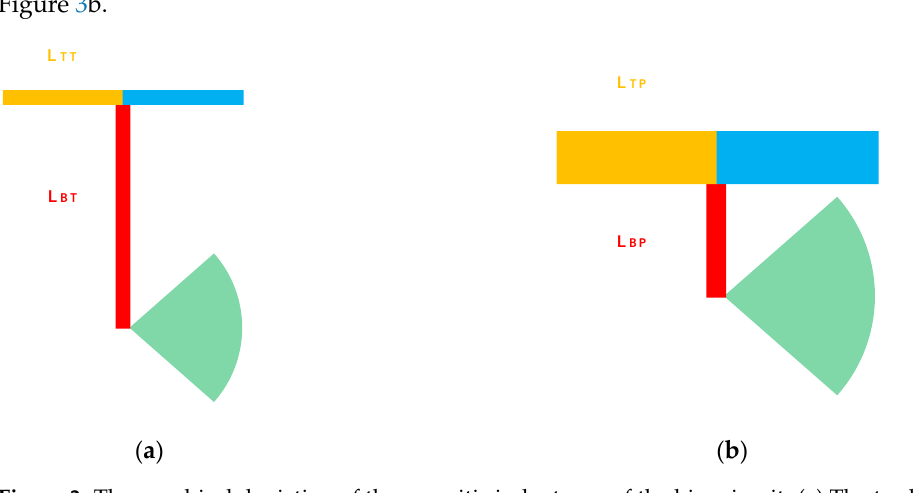
Figure 3. The graphical depiction of the parasitic inductance of the bias circuit. ( a ) The traditional bias circuit. ( b ) The proposed bias network.